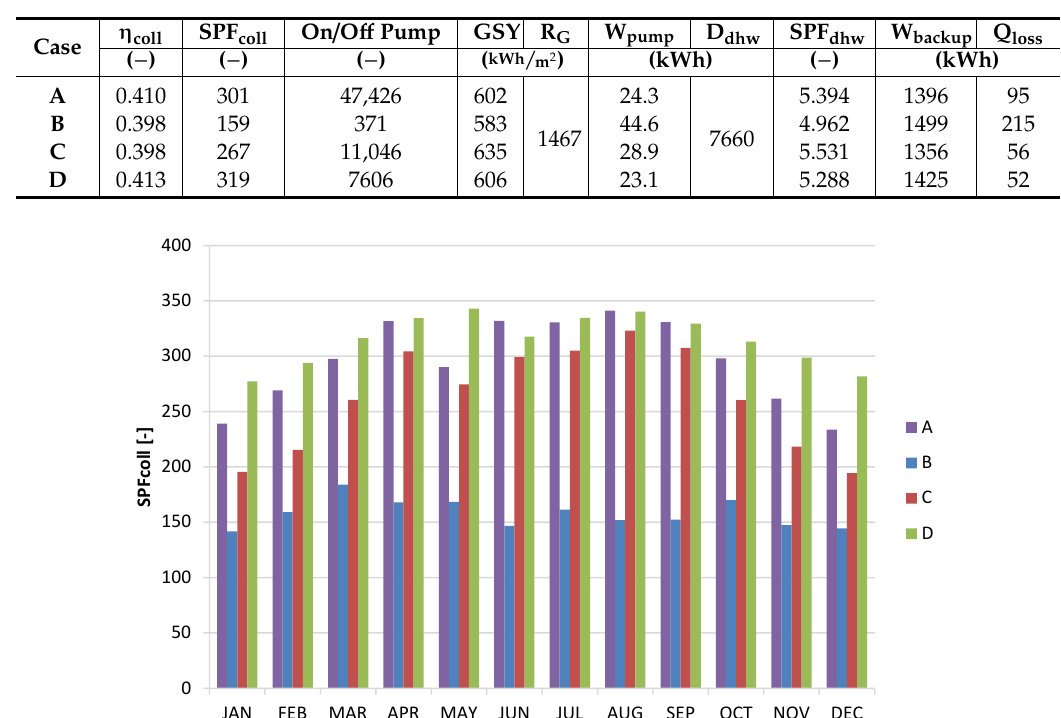
Figure 6. Monthly profile of the SPF coll between the four different control strategies.